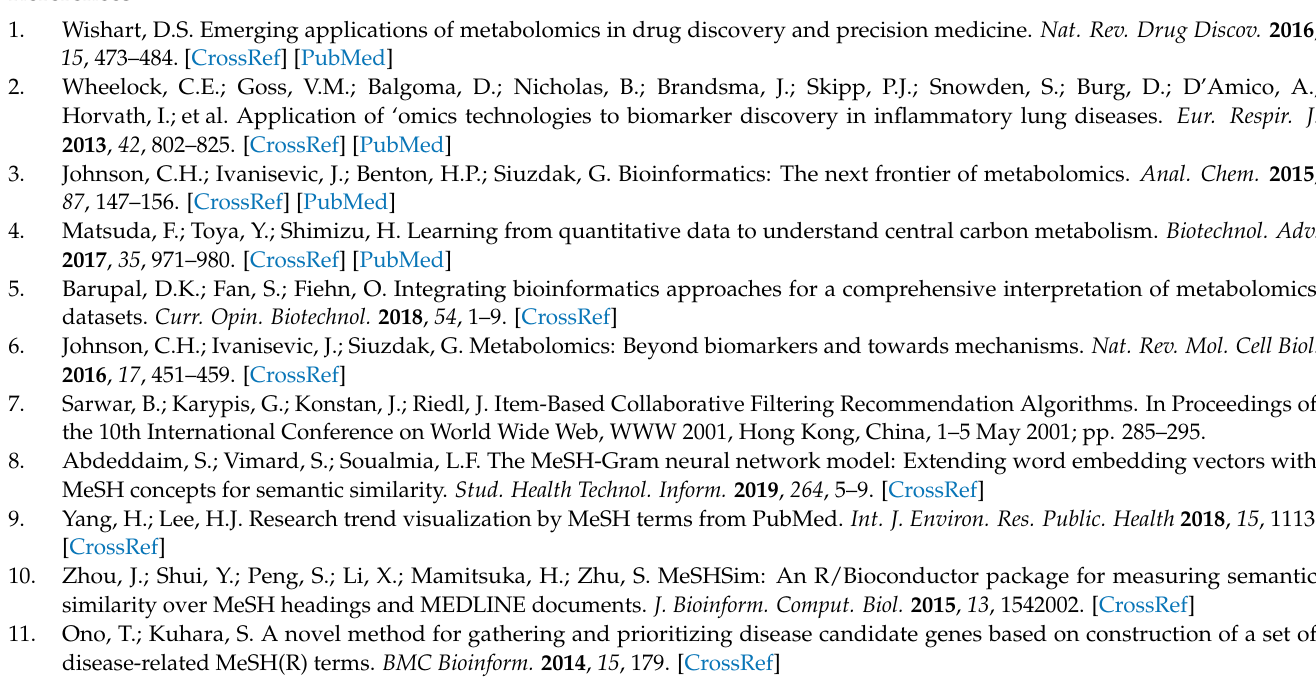
Figure S2: Connectivity between metabolites and diseases in literature, Table S1: Medical Subject Heading (MeSH) terms recommended based on sarcosine and prostatic neoplasms using confidence (RL) method at a false discovery rate (FDR) level of <0.01, Table S2: Comparison of the scoring methods using the two negative control example MeSH terms (false discovery rate level < 0.01), Table S3: Comparison of the scoring methods using the two negative control example MeSH terms (false discovery rate level < 0.01), Supplementary manual of software, Data S1: Subset of MeSH Terms related to primary metabolism metabolomics, Data S2: MeSH terms recommended from metabo- lite (Leucine (D007930)) and known keyword (diabetes mellitus, type 2 (D003924)) (FDR < 0.01), Data S3: Result of the over-represent analysis of the 291 MeSH terms recommended from leucine and diabetes mellitus, Type 2, Data S4: Numbers of MeSH terms obtained by the developed method among 145 metabolites and 39 diseases (FDR <